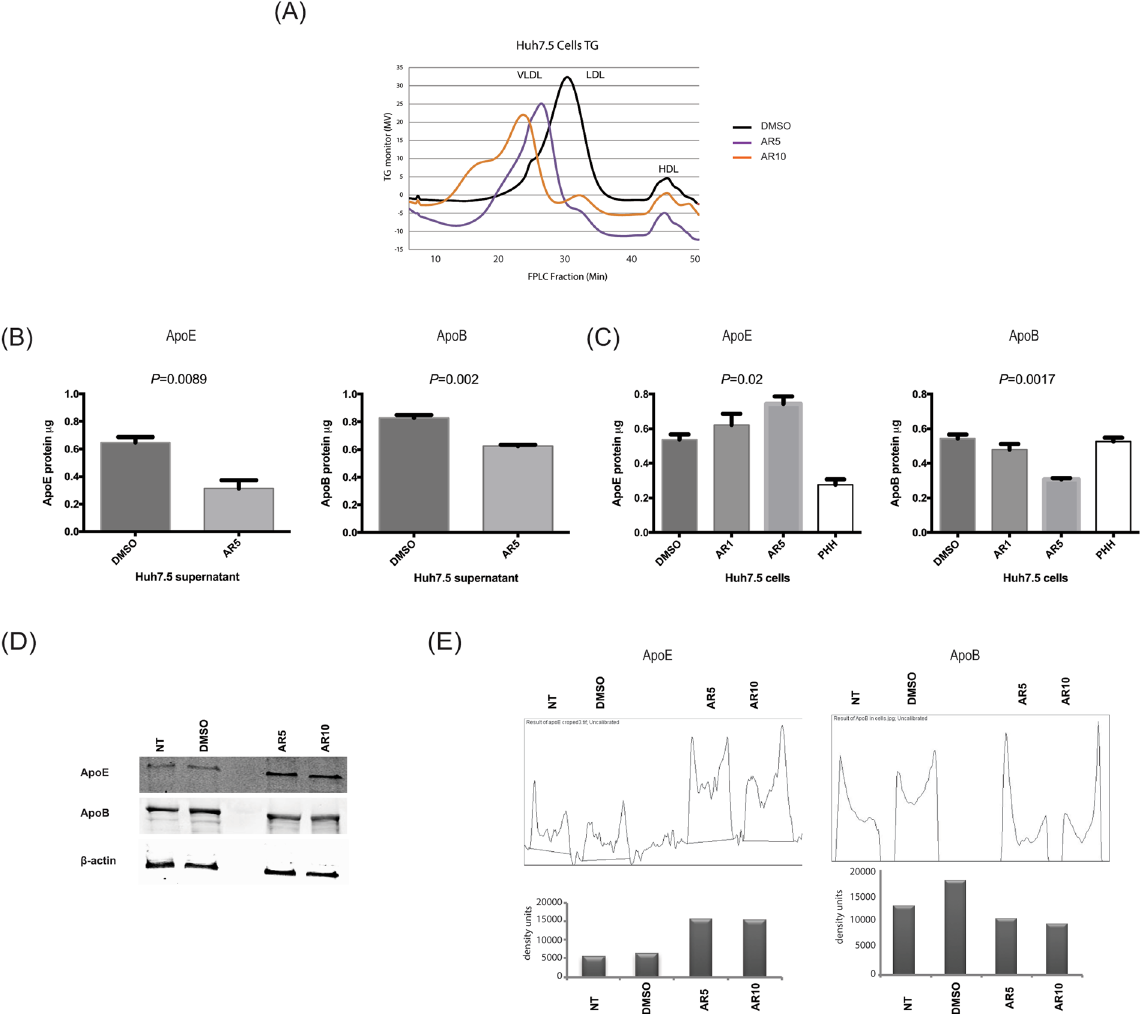
Figure 6. Decreased secretion of ApoE and synthesis of ApoB by Huh7.5 cells treated with GSK3 β inhibitors. ( A ) FPLC shows dose dependent decrease in number and size of VLDL and LDL particles secreted by Huh7.5 cells treated with AR5 and AR10. ( B ) Decreased secretion of ApoE and ApoB protein by AR5-treated Huh7.5 cells. ( C ) A dose-dependent increase of ApoE and a decrease of ApoB synthesis inside the cells was noticed in AR1 and AR5 treated cells. PHH cells were used as a positive control for ApoE and ApoB protein expression and show a higher concentration of ApoB compared to ApoE. ( D ) ApoE and ApoB protein were detected in the same cells by western blotting on 5% SDS-polyacrylamide gels using specific mAb. The picture was cropped from the actual blot. ( E ) Densitometry plots for quantification of the bands in the western blot in panel ( D ), confirm the increase in intracellular ApoE (left panels) and decrease in intracellular ApoE. FPLC, fast protein liquid chromatography, mAb, monoclonal antibodies, PHH, primary human hepatocytes, VLDL, very low density lipoprotein. The results are presented as the mean ± SD (n = 3 independent